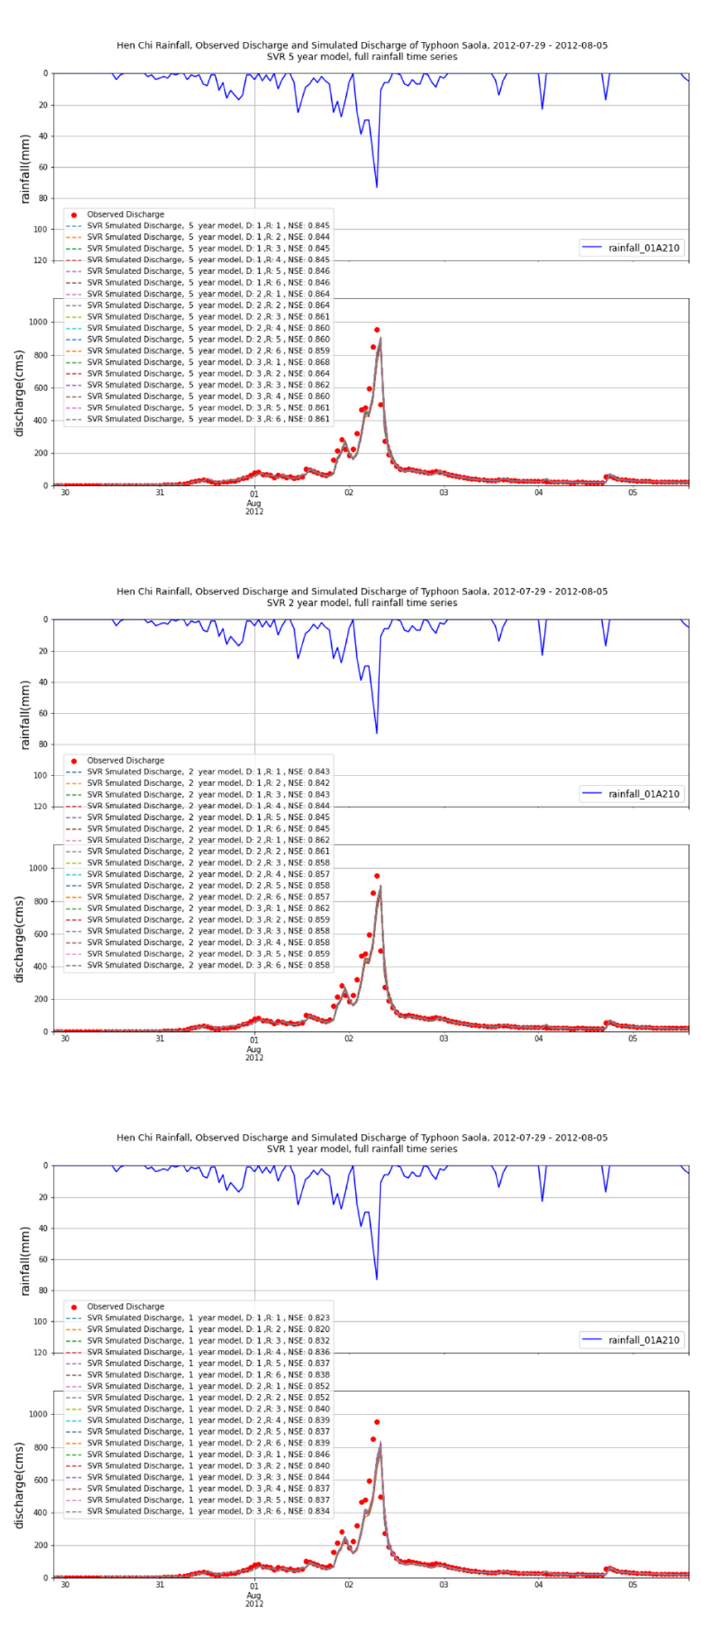
Figure 6. The testing results derived from the Type 1 SVR model using different features selection for Typhoon Saola. D 1 to 3 represents discharge features of the previous 1 to 3 h, while R 1 to 6 indicates rainfall features of the previous 1 to 6 h.